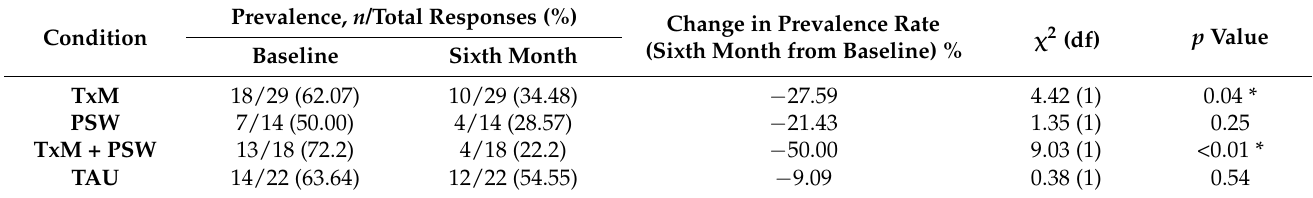
Table 3. Prevalence change of risk scores across the four study arms from baseline to six